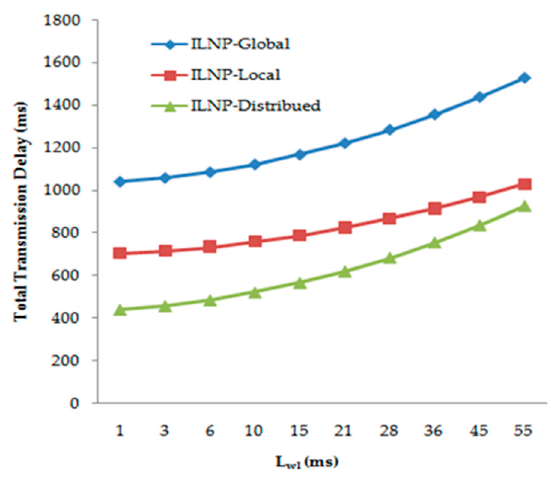
Figure 12. Impact of L wl on TTD.